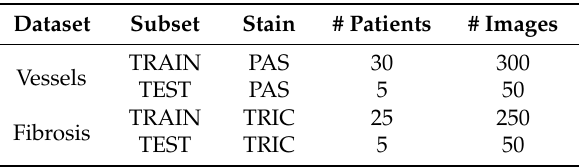
Table 1. Dataset used in this